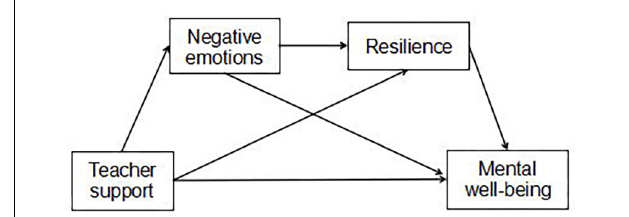
FIGURE 1 | The proposed mediation